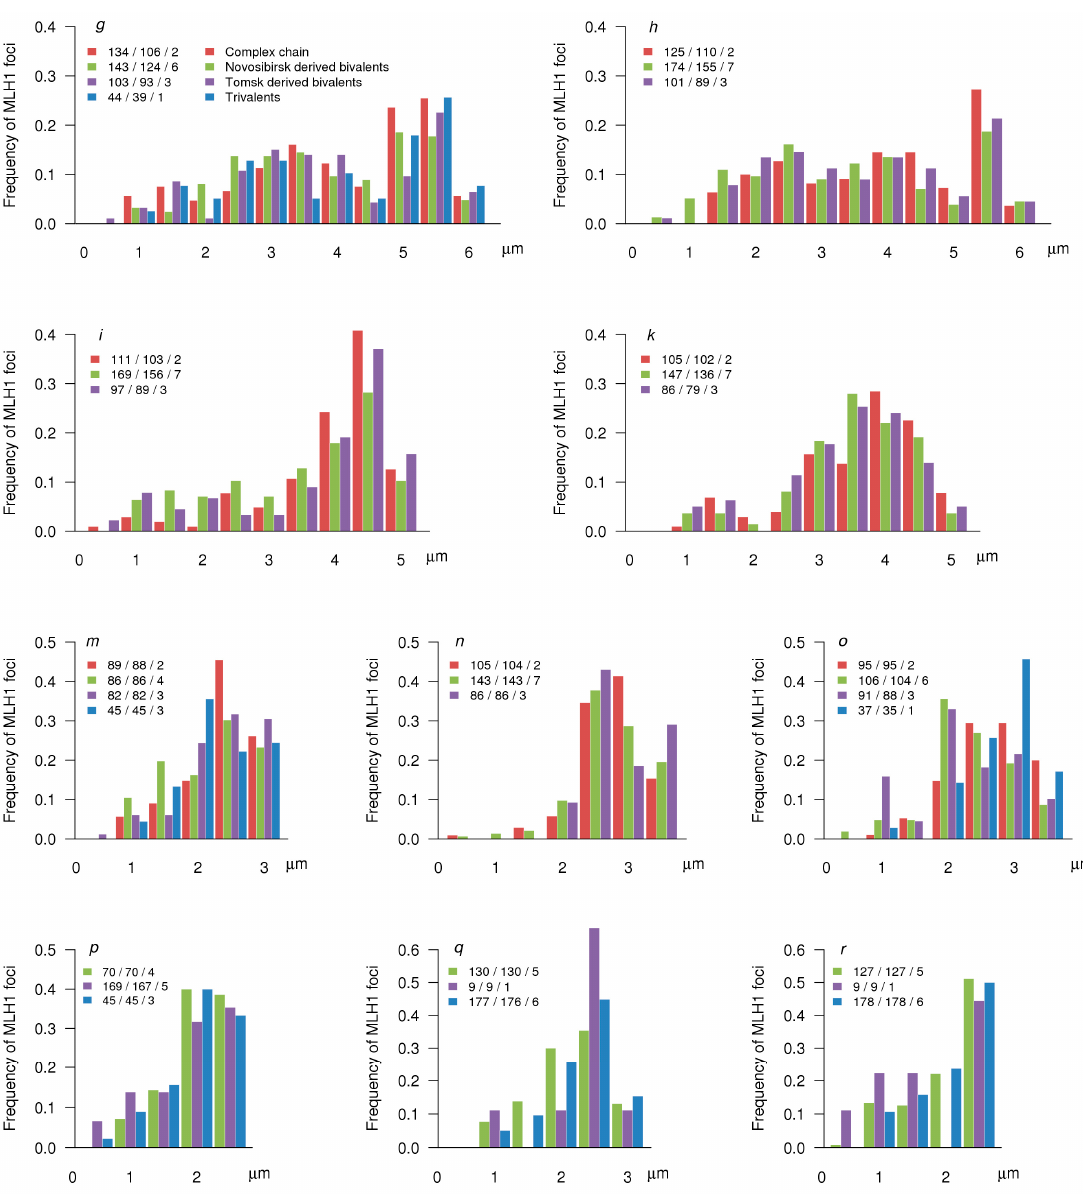
Figure 8. Distribution of MLH1 foci along the arms of variable chromosomes. The X-axis shows the position of MLH1 foci in relation to the centromere (marked by 0) at the SC of particular arm (indicated at the top of each graph). The labels on the X-axis are separated by 1 µm of the SC. The Y-axis indicates the frequency of MLH1 foci in each 0.5 µm interval. The numbers in the legends above each plot show the number of MLH1 foci/arms/specimens plotted.